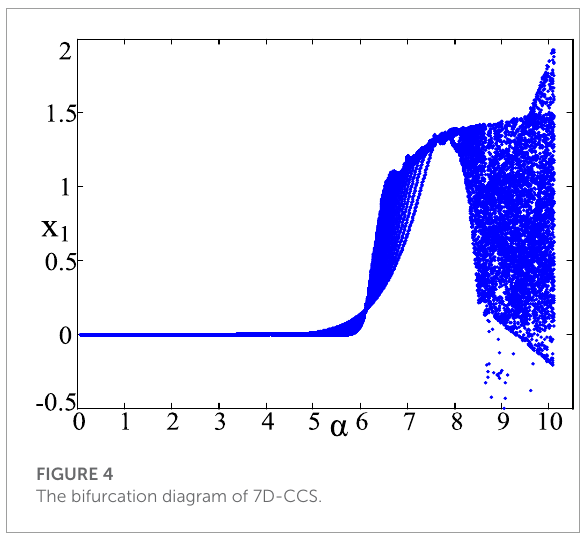
FIGURE 4 The bifurcation diagram of 7D-CCS.